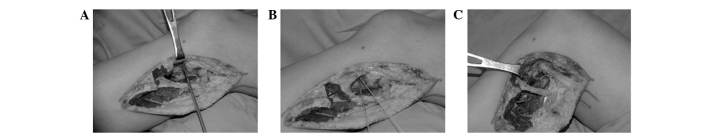
The lateral collateral ligament and biceps femoris tendon are reattached to the lateral tibial metaphysis following type I en bloc resection using suture anchors with a 20º knee flexion.